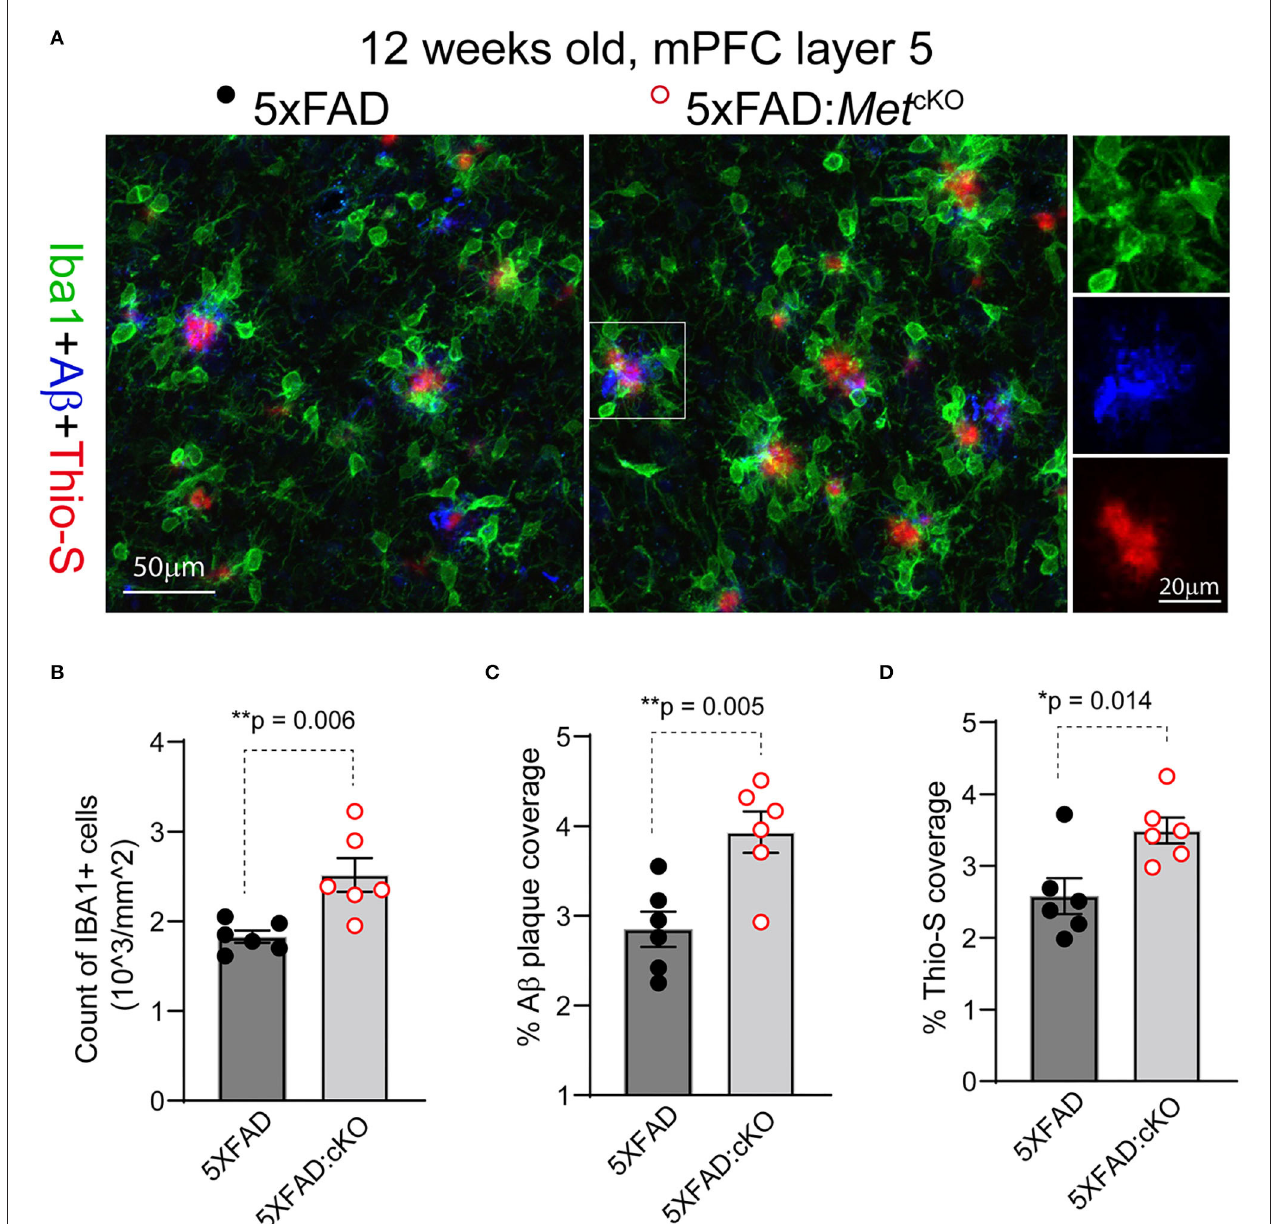
FIGURE 2 | Genetic ablation of MET signaling exacerbates A β -related neuropathology. (A) Representative confocal images showing triple staining of Iba1/APP-A β /Thio-S in 12-week-old 5XFAD and 5XFAD: Met cKO mice mPFC L5 regions. (B) Quantification of density of Iba1 + active microglia. 5XFAD: Met cKO mice show significantly increased microglia density (** p = 0.006). (C) Quantification of density of APP/A β + plaque area. 5XFAD: Met cKO mice show significantly increased plaque coverage (** p = 0.005). (D) Quantification of Thio-S + percentage areas. Increased Thio-S + coverage was seen in 5XFAD: Met cKO mice (* p = 0.014).